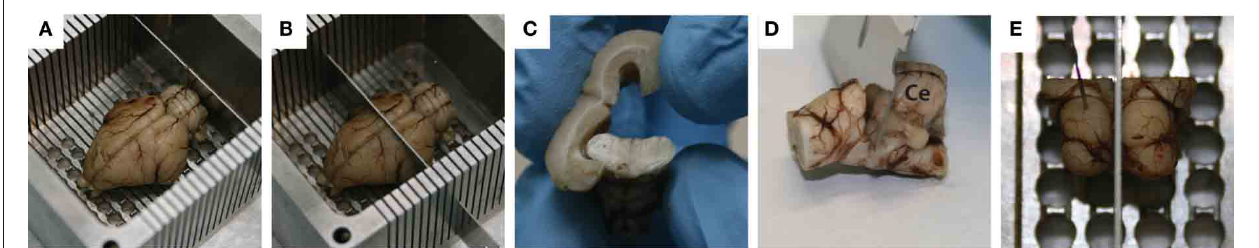
FIGURE 2 | Standard blocking procedure for extracting the midbrain. With the brain pinned to the custom-made slicing box through the frontal lobe and the cerebellum, a coronal slice was made caudal of the cerebellum to remove the spinal cord (A) , while a second coronal slice was made through the center of the temporal lobes to remove the rostral half of the brain (B) . A frontal view of the cortex being peeled away from the